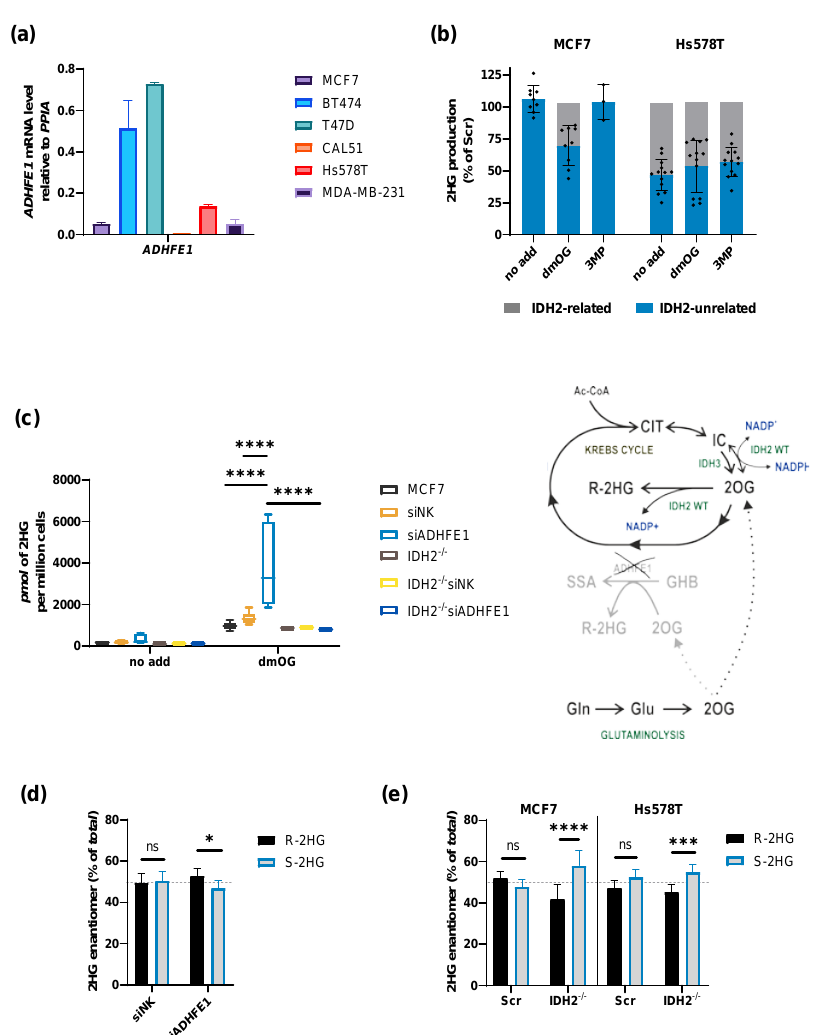
Figure 3. 2HG production by IDH2 and ADHFE1. ( a ) Quantification of the expression level of ADHFE1 measured by qPCR. ( b ) IDH2-related and IDH2-unrelated portions of 2HG were produced in MCF7 and Hs578T cells, respectively. IDH2-related portions were calculated indirectly comparing IDH2 +/+ (scrambled, Scr) and IDH2 − / − cell lines, respectively. See also Figure S3a,b for actual experiments. ( c ) 2HG levels in MCF7 cells, transfected with non-targeting siRNA (siNK) and siRNA targeting ADHFE1 (siADHFE1), non-treated and treated with dmOG (2 mM, 6 h). n = 9. Two-way ANOVA. Right: scheme depicting the experimental design, i.e., substrate flow after knockdown of ADHFE1 using siRNA. GHB stands for gamma -Hydroxybutyric acid and SSA for succinyl-semialdehyde. ( d ) Per-cent of R-HG and S-2HG in MCF7 cells, transfected with non-targeting siRNA (siNK) and siRNA targeting ADHFE1 (siADHFE1). n = 6. Two-way ANOVA. ( e ) Per-cent of R- and S-2HG in MCF7 and Hs578T cells, Scr and IDH2 − / − clones. n > 6. Two-way ANOVA. * p < 0.05, *** p < 0.001, **** p < 0.0001, ns not statistically significant